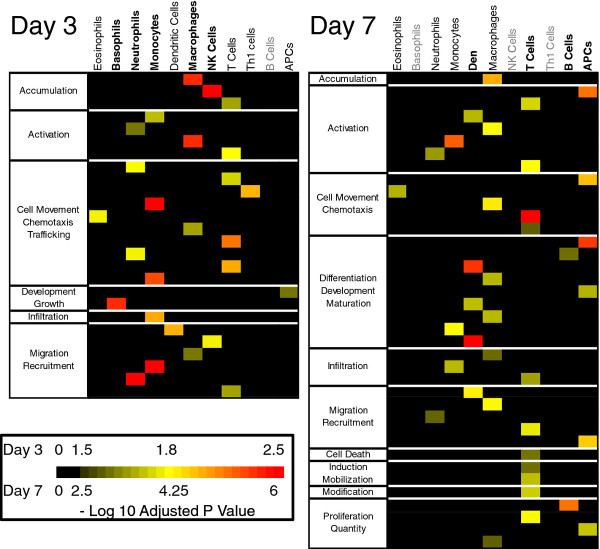
Cell-specific CA04-induced functional enrichment. Cell-type specific enrichment of CA04-induced up-regulated DE transcripts is shown for day 3 (left) and day 7 (right) post-infection. Enriched cell-type-specific IPA annotations (FDR-adjusted P-value < 0.05) were sorted according to function (categories shown to the left of each panel) and cell-type (shown at the top of each panel), and the level of enrichment was illustrated by a heat map showing the -log10-adjusted P-value for each annotation. Because P-values associated with highly related annotations (e.g., ‘Cell Movement’, ‘Chemotaxis’ and ‘Trafficking’) were grouped together, a cell type could be enriched several times within a particular category. Cell types with the highest enriched categories are shown in boldface (top), whereas cell types for which no categories were enriched are shown in grey. All other cell types, exhibiting intermediate levels of enrichment in various categories, are represented in normal black text. A color-key for the heat map is shown at the lower left of the figure, in which day 3 P-values are represented by the range above the color bar and day 7 P-values are indicated below the bar.